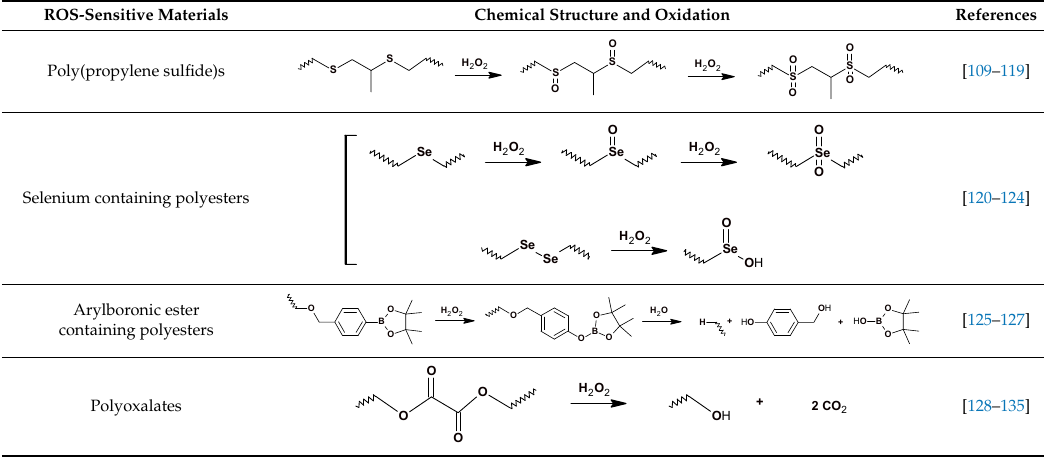
Table 1. Representative oxidation-responsive polyesters and their oxidation products.